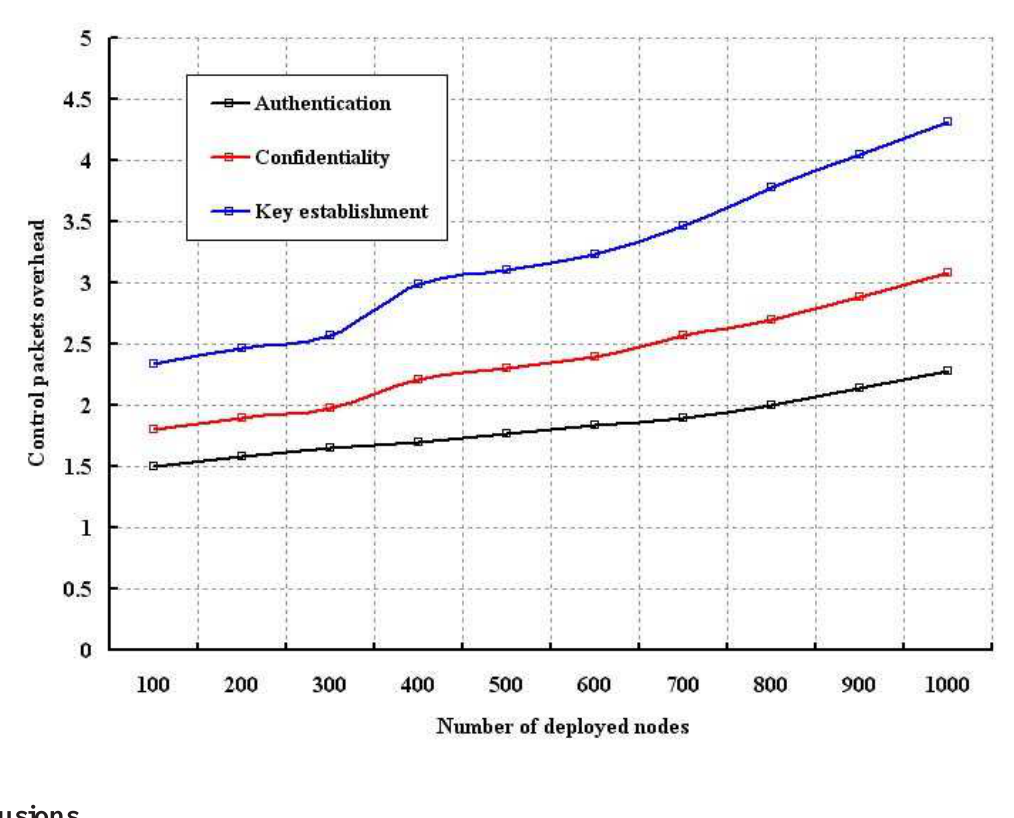
Figure 13. Control packet overhead with different number of